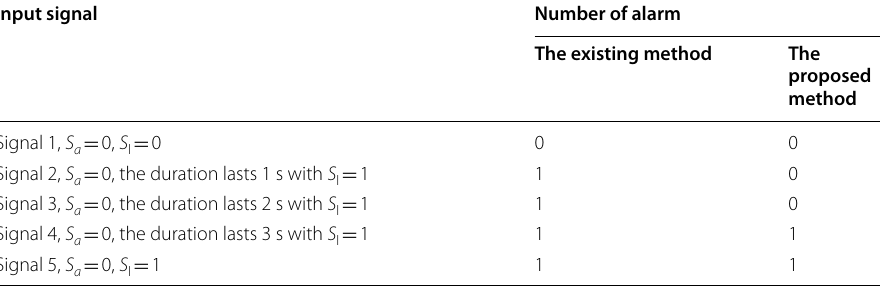
Table 4 Comparison of the number of alarms for the abnormal lock opening Input signal Number of alarm